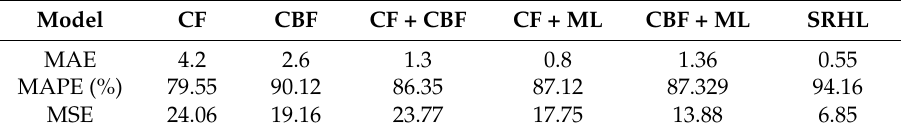
Table 11. Result comparison with SRHL and others with FM =